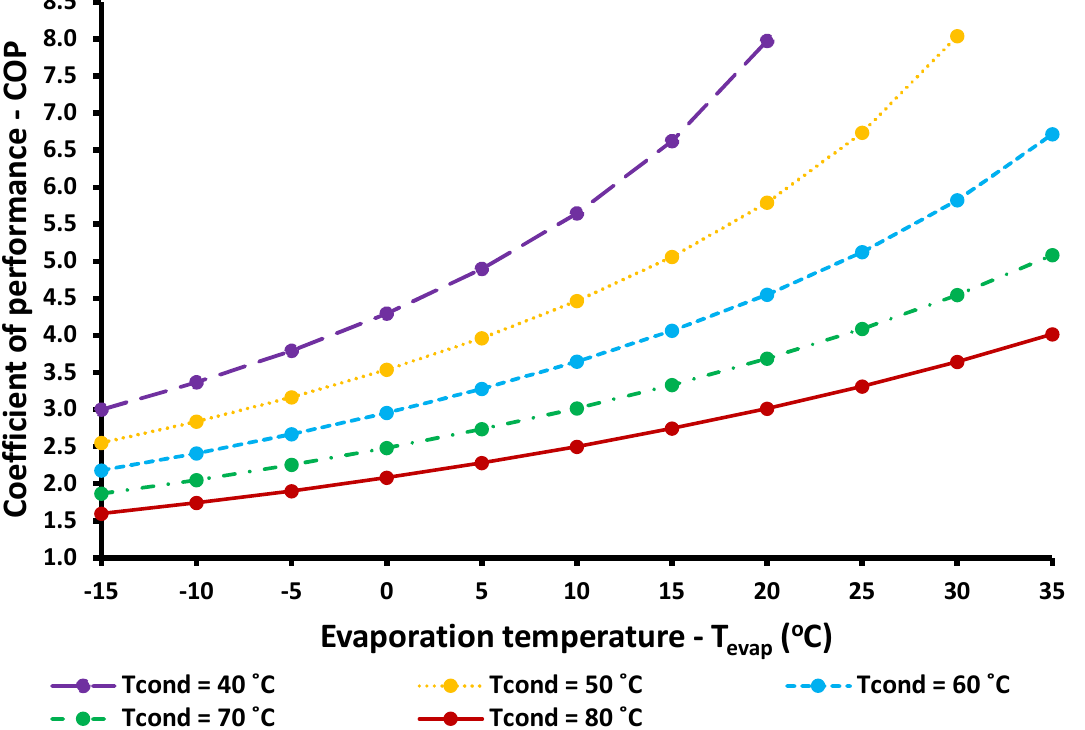
Figure 2. Performance of the heat pump for different operating conditions.